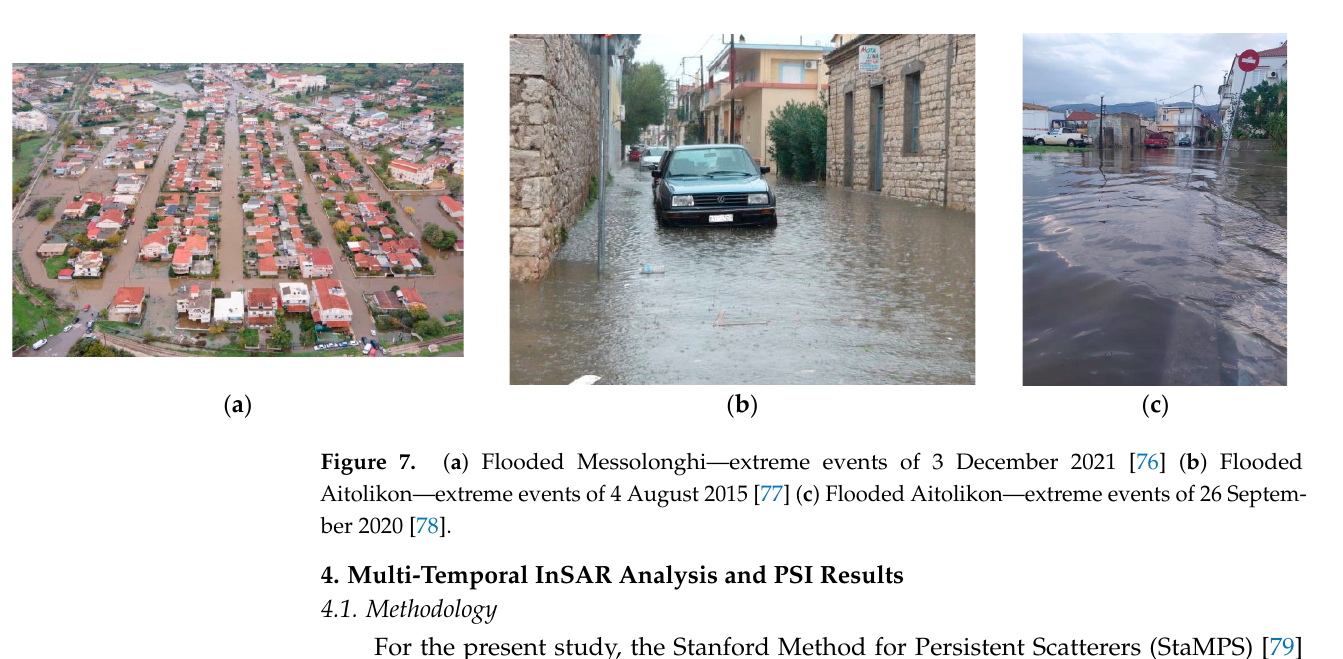
Figure 6. ( a ) Flooded sections of Messolonghi in 2100 according to SSP5-8.5 sea level assumption ( b ) Flooded sections of Aitolikon in 2100 according to SSP5-8.5 sea level assumption.